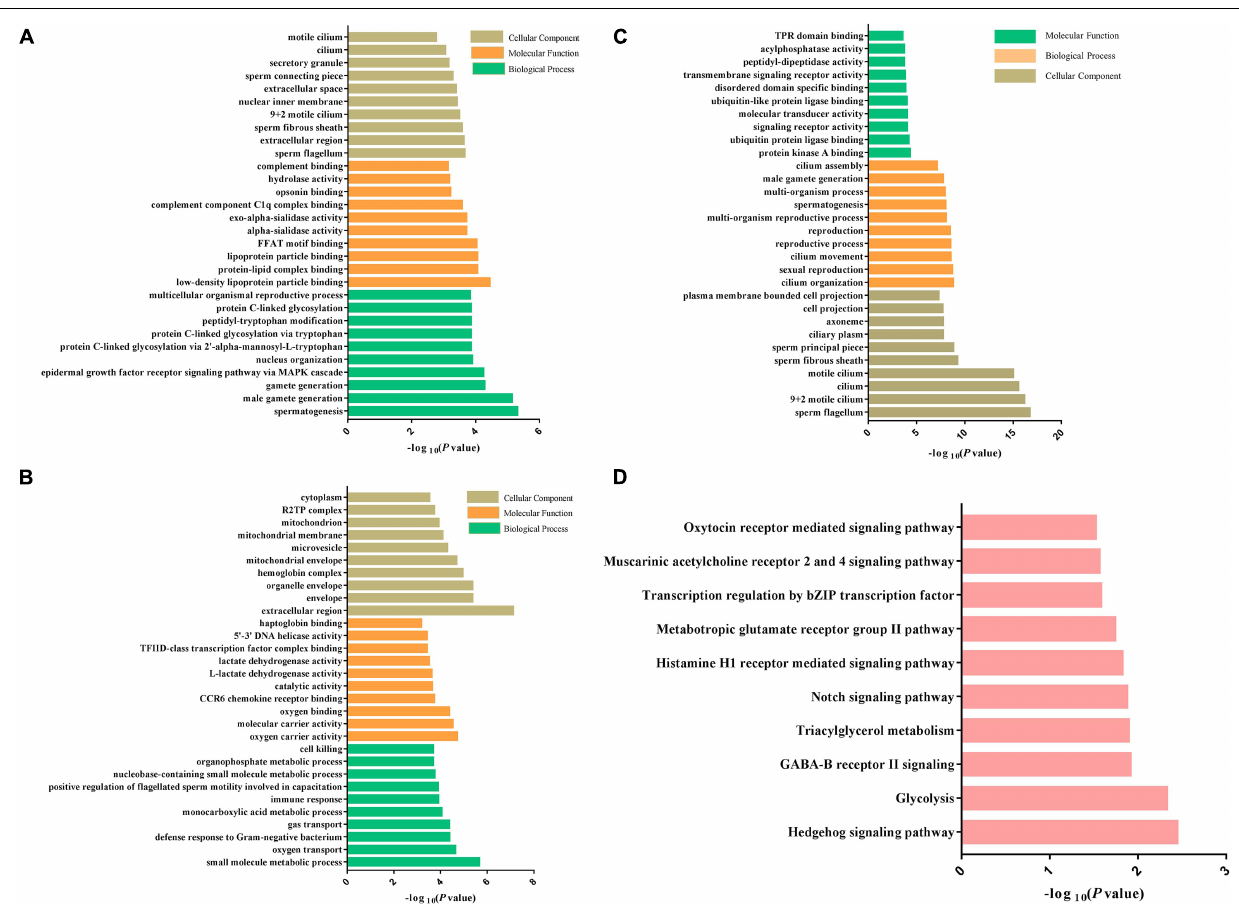
FIGURE 6 | Bioinformatics analysis of the DEPs and DPPs between Yorkshire and Duroc boar Spermatozoa. (A) Downregulated DEP GO terms. (B) Upregulated DEP GO terms. (C) GO enrichment analysis of the DEPs between Yorkshire and Duroc boar spermatozoa. (D) The top 12 KEGG pathways in the DPPs between Yorkshire and Duroc boar